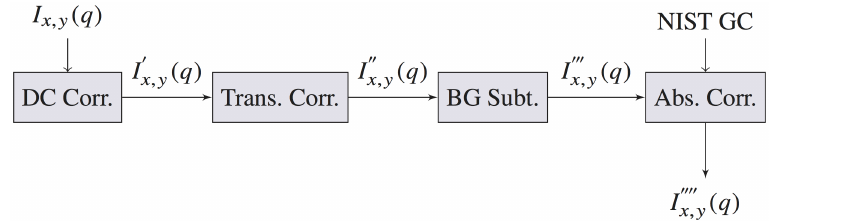
Fig 2. Block diagram of pSAXS data